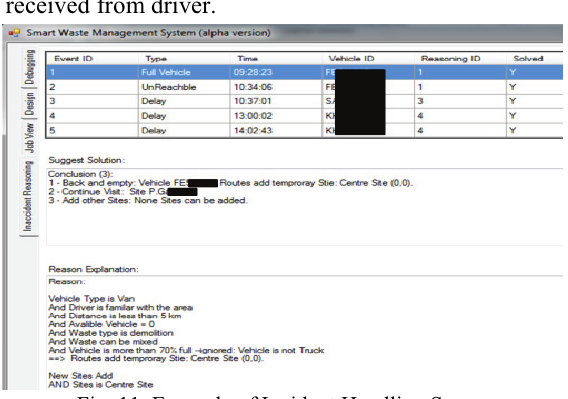
Fig. 11. Example of Incident Handling Screen